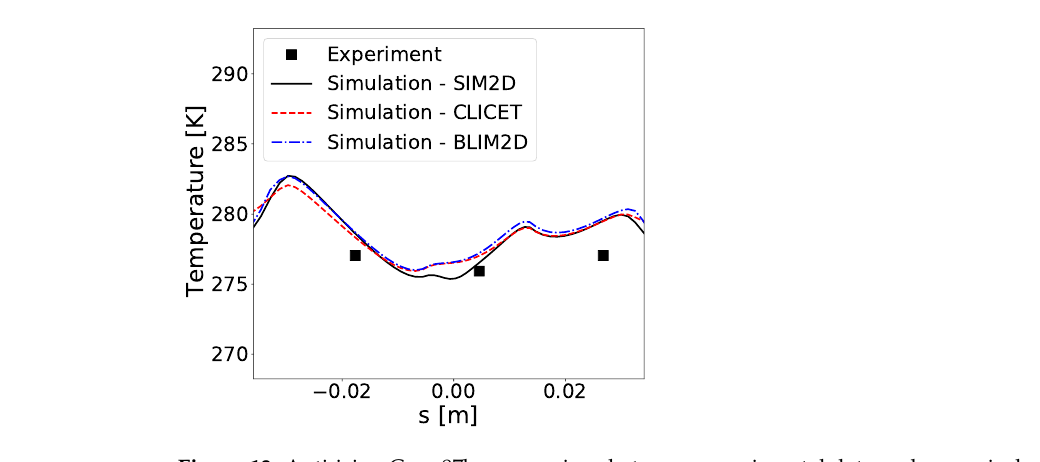
Figure 13. Anti-icing Case 87b: comparison between experimental data and numerical results (in the laminar region) obtained with a coupling with SIM2D, CLICET, and BLIM2D.